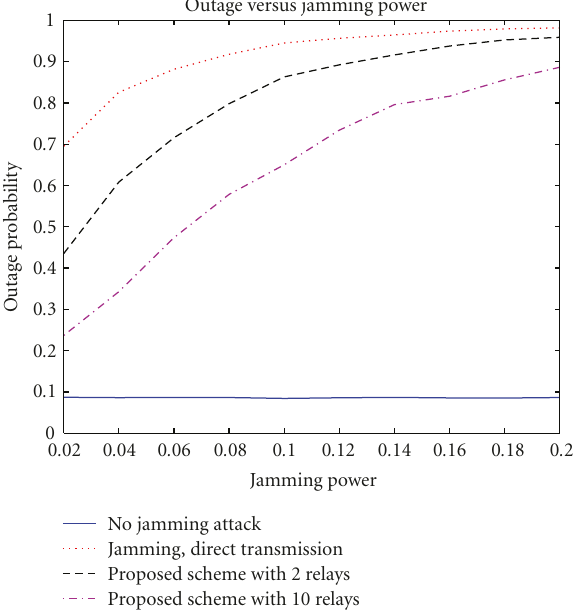
Figure 7: Outage probability versus jamming power.